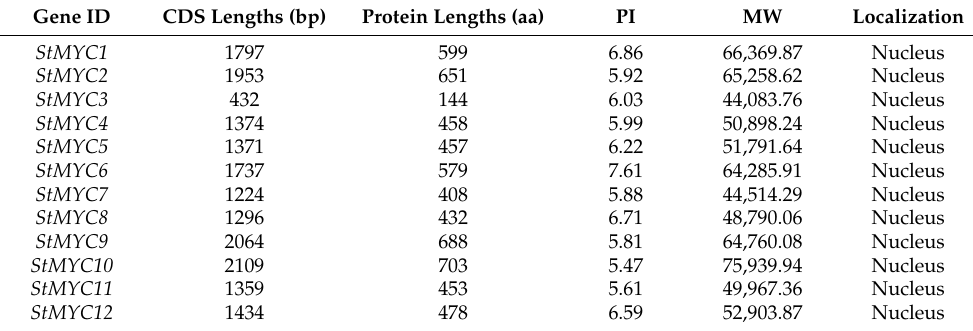
Table 2. Characteristics of 12 family members of the MYC gene in Solanum tuberosum .